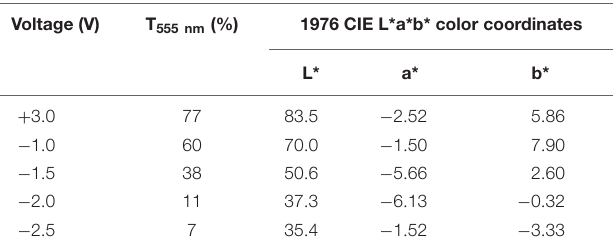
TABLE 1 | Electro-optical parameters of the glass/ITO/a-WO 3 /d-Ut(600) 10 LiCF 3 SO 3 [Bmim]Cl/c-NiO/ITO/glass